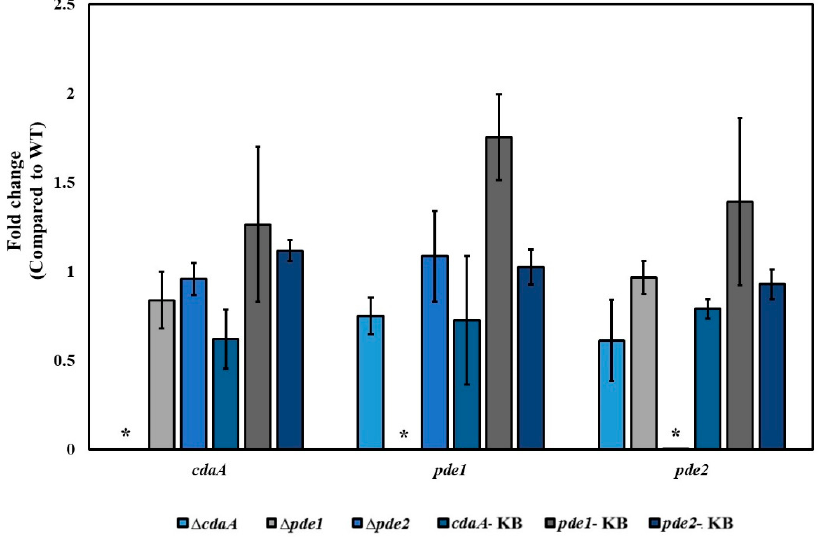
Figure 4. Transcription of genes related to c-di-AMP turn-over assessed by RT-qPCR. The gene encoding one of the subunits of DNA gyrase ( gyrA ) was used as reference gene. The relative transcription level of each gene in the mutants compared to the WT was calculated by the ΔΔ Cq-method. Shown are mean-values and standard error of the mean based on two independent experiments. * indicates statistical significance ( p < 0.05).